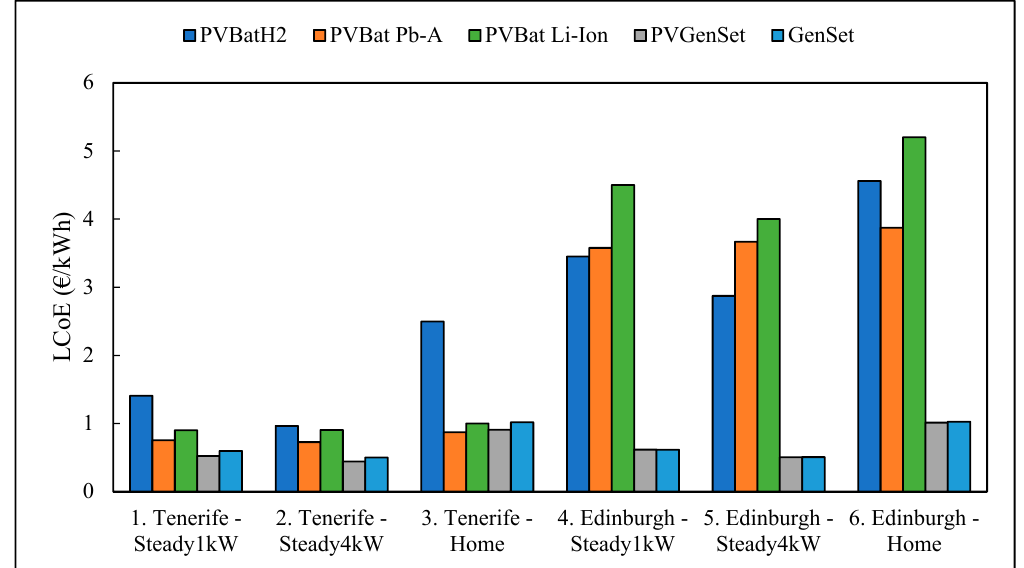
Figure 5. Economic results for systems in competition with Ely4off for each one of the six scenarios.